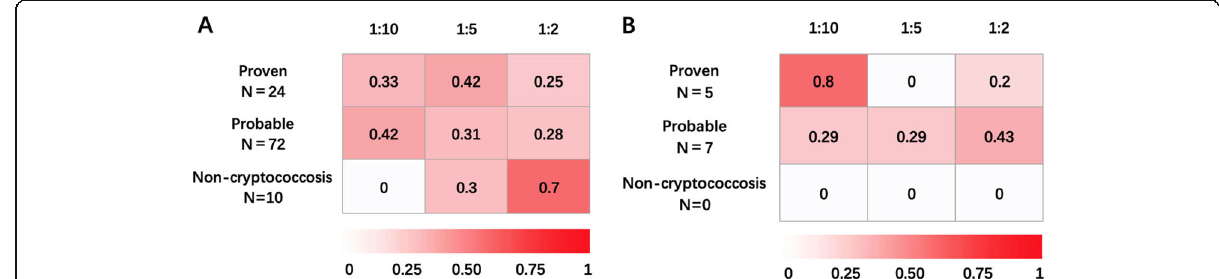
Fig. 2 Heat map of patients with cryptococcosis and CrAg titers. A . Heat map of patients with cryptococcosis and CrAg titers in serum. B . Heat map of patients with cryptococcosis and CrAg titers in CSF. The proportion of patients with cryptococcosis in each diagnostic classification and the corresponding CrAg titer value in serum or CSF are illustrated. The intensity of the red color increases with of greater proportion of patients falling with corresponding CrAg titer and diagnostic classifications. Abbreviations: CrAg, cryptococcal antigen; CSF, cerebrospinal fluid.